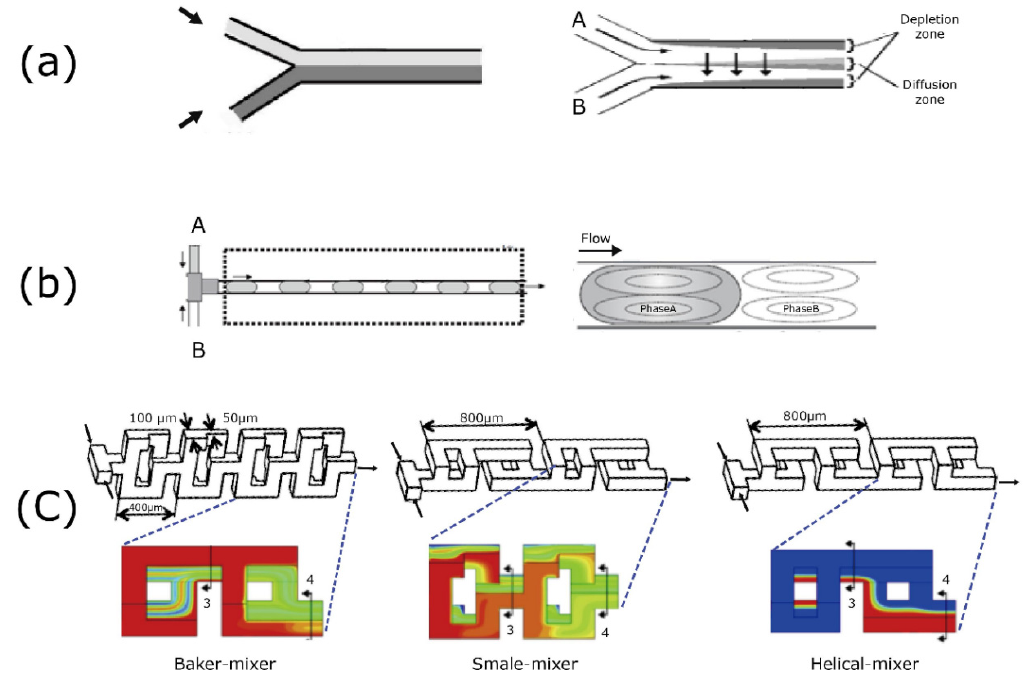
Figure 4. Schematic and flow pattern of microreactor flow systems for ( a ) laminar flow [114], ( b ) slug flow [126], and ( c ) integrated flow [124].